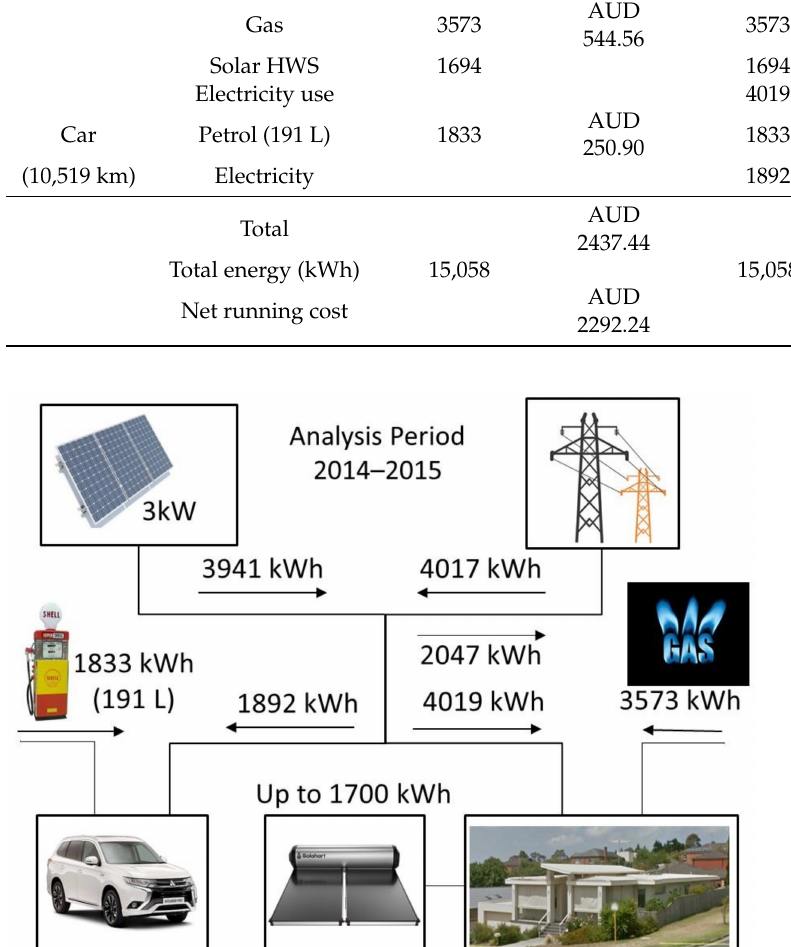
Figure 2. Household energy flows (July 2014–June